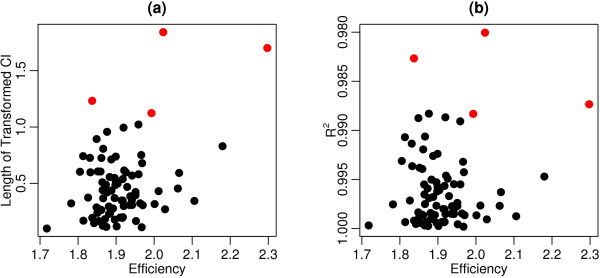
In panel (a) length of the transformed confidence intervals are shown on the vertical and primer efficiency on the horizontal axis. In panel (b) the squared regression coefficient is shown on the vertical and primer efficiency on the horizontal axis. Transformed CI outliers are colored red in both panels. Outliers not shown are primers 73-5'UTR, orf24-306F and orf35-200F, with transformed CI lengths 6.95, 58.0 and 4.93 × 1015, respectively.